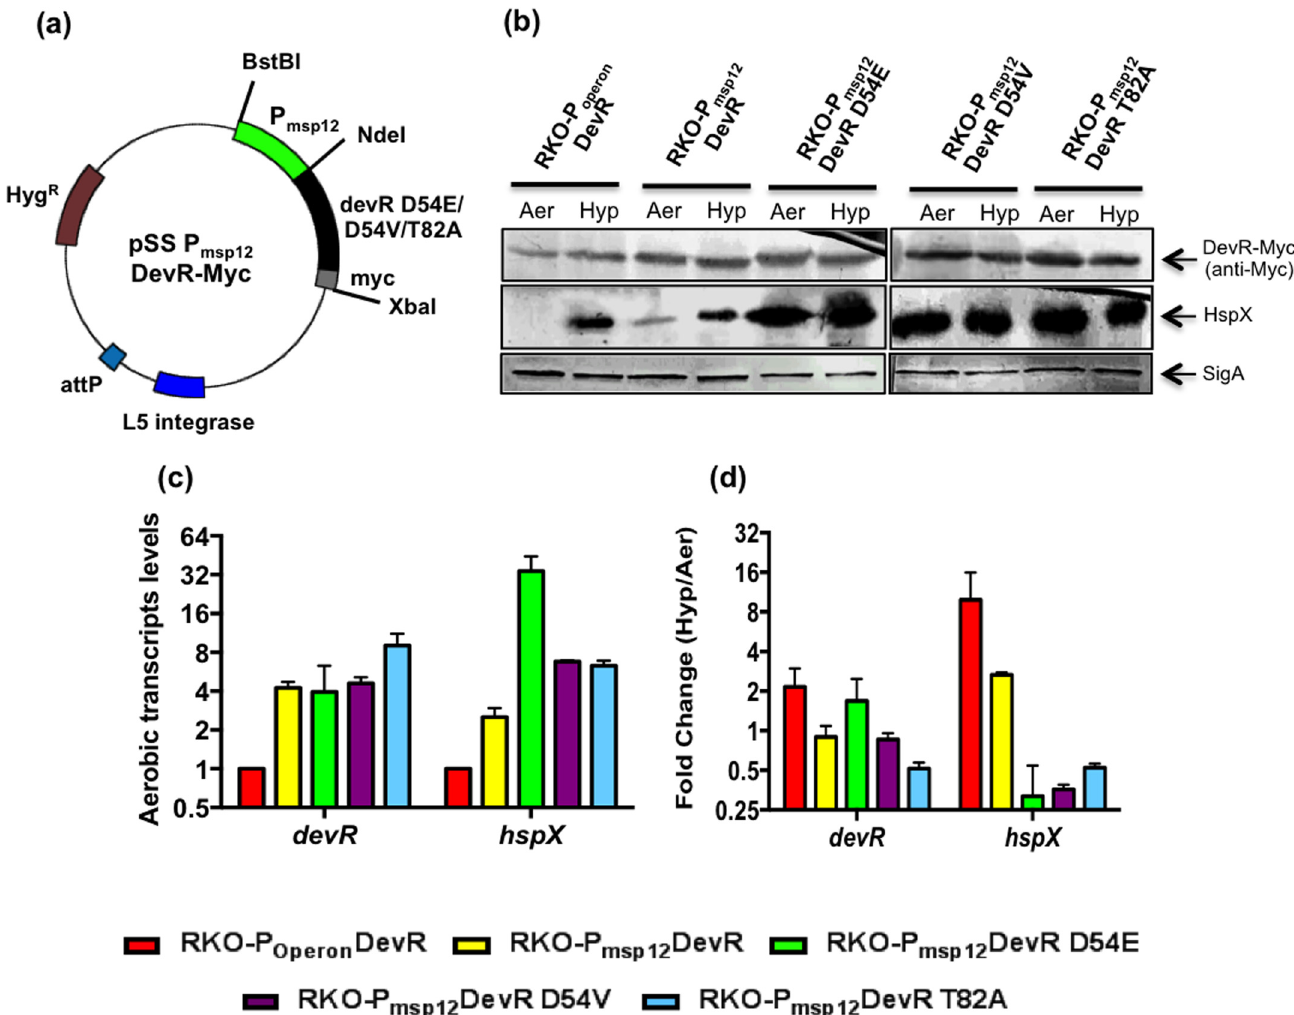
Fig 2. Overexpression of WT/mutant DevR in Mtb RKO. (a) Vector map of integrating plasmid overexpressing WT/mutant DevR proteins. (b) Mtb RKO- P msp12 DevR, RKO-P msp12 DevR D54E, RKO-P msp12 DevR D54V and RKO-P msp12 DevR T82A strains overexpress DevR variants from msp12 promoter. RKO-P Operon DevR strain expresses DevR from its native promoter. Western blotting of aerobic (Aer) and 5 day hypoxic (Hyp) cultures lysates. A representative blot is shown. (c) RT-qPCR analysis of regulon genes in aerobic cultures. (d) RT-qPCR analysis of DevR regulon genes under hypoxia. RT-qPCR data is Mean ± SD of 2 biological replicates. SigA was used as a loading control in